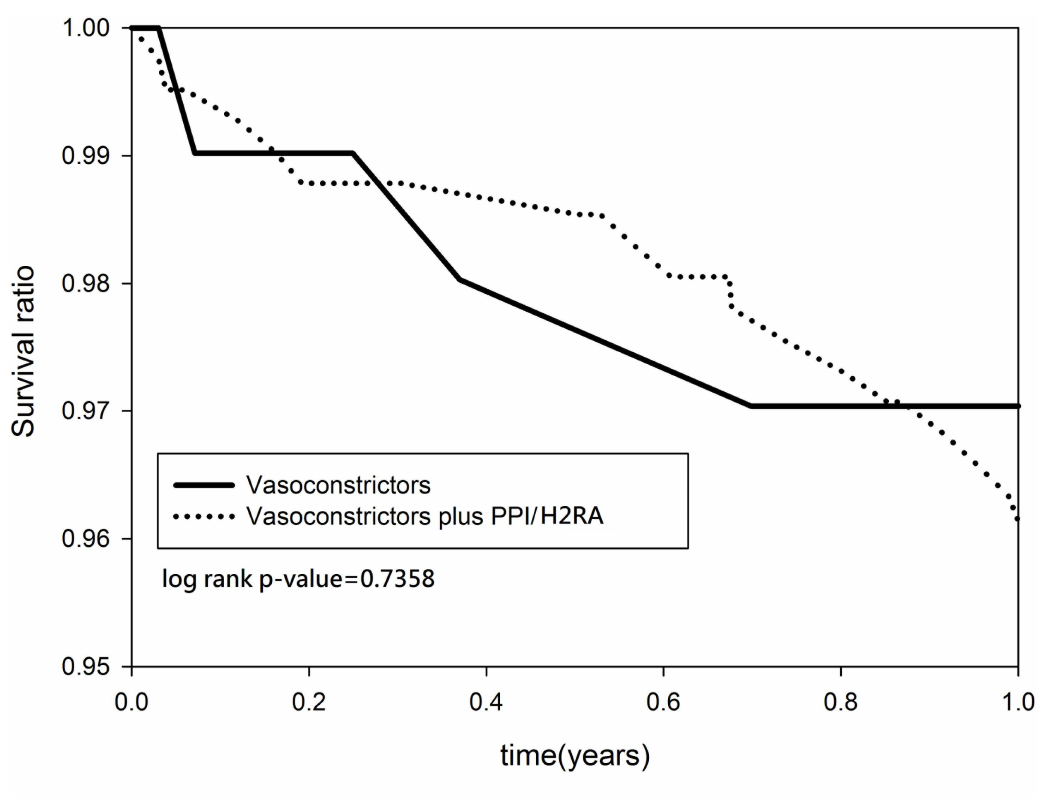
Fig 4. Kaplan–Meier estimatesfor survival in patients with cirrhosis and esophageal variceal bleeding (1 year